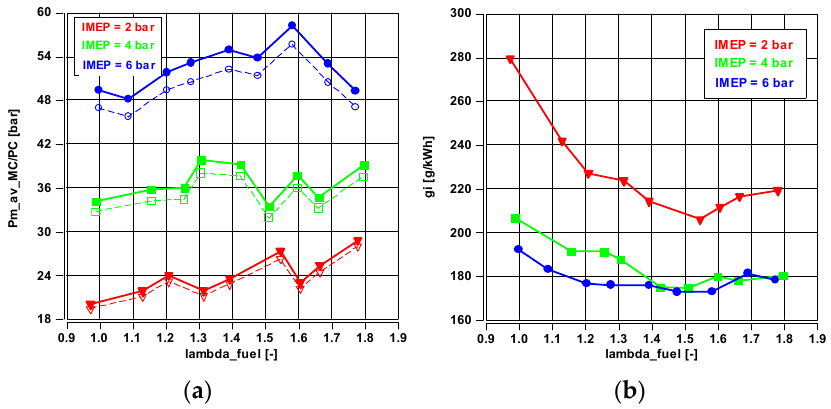
Figure 11. Operating indicators of the tested engine: ( a ) average maximum pressure values in the main chamber and in the prechamber; ( b ) specific indicating fuel consumption vs. lambda-value.